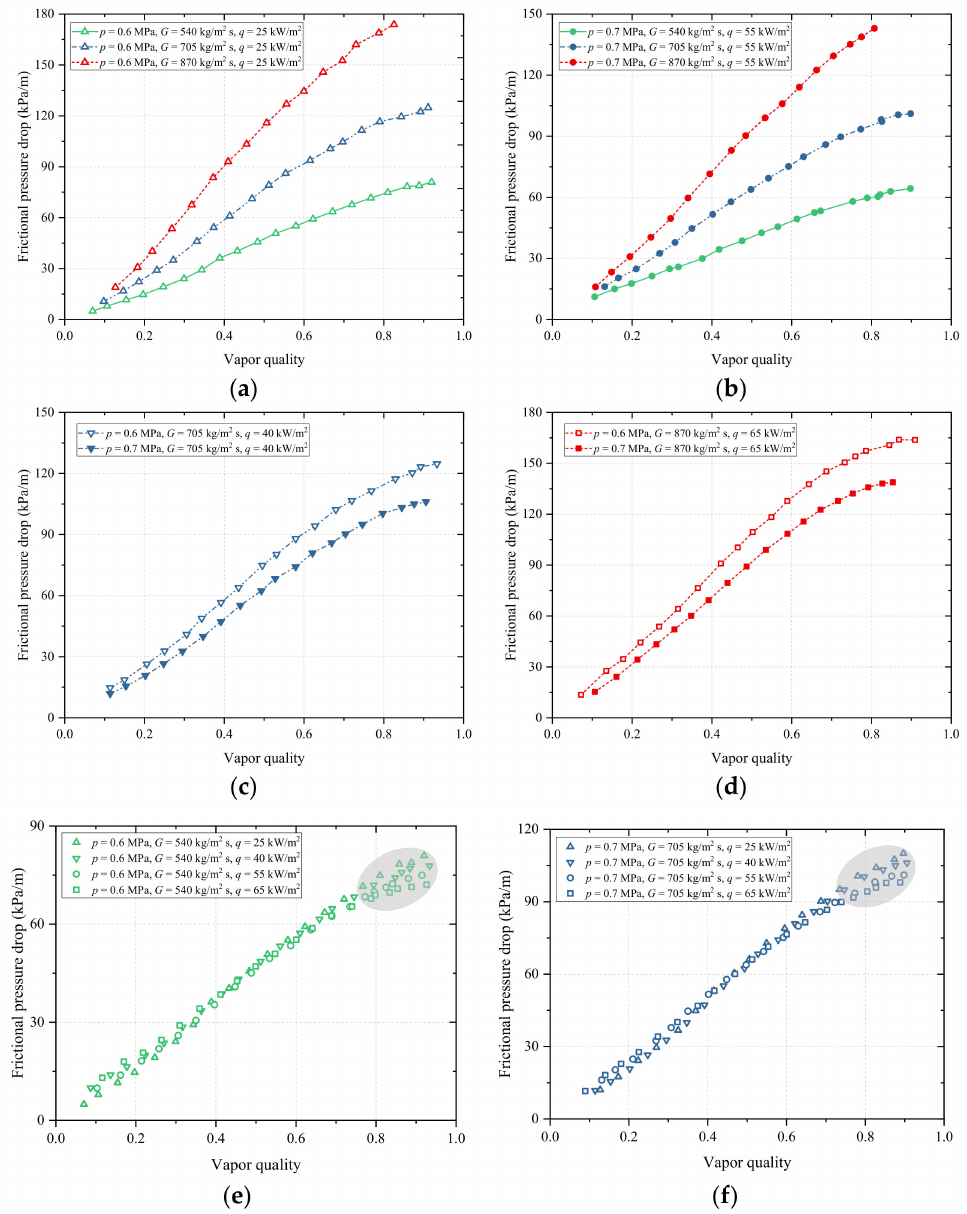
Figure 8. Flow boiling FPD of R1234ze(E) versus vapor quality: ( a ) effect of mass flux on FPD at p = 0.6 MPa and q = 25 kW/m 2 ; ( b ) effect of mass flux on FPD at p = 0.7 MPa and q = 55 kW/m 2 ; ( c ) effect of saturation pressure on FPD at G = 705 kg/m 2 s and q = 40 kW/m 2 ; ( d ) effect of saturation pressure on FPD at G = 870 kg/m 2 s and q = 65 kW/m 2 ; ( e ) effect of heat flux on FPD at p = 0.6 MPa and G = 540 kg/m 2 s; ( f ) effect of mass flux on FPD at p = 0.7 MPa and G = 705 kg/m 2